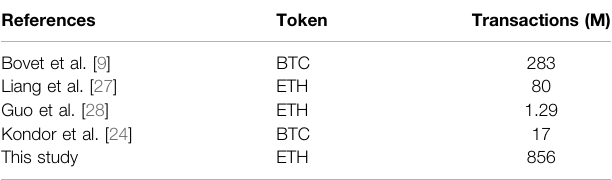
TABLE 1 | Summary of the different datasets analysed by different authors.